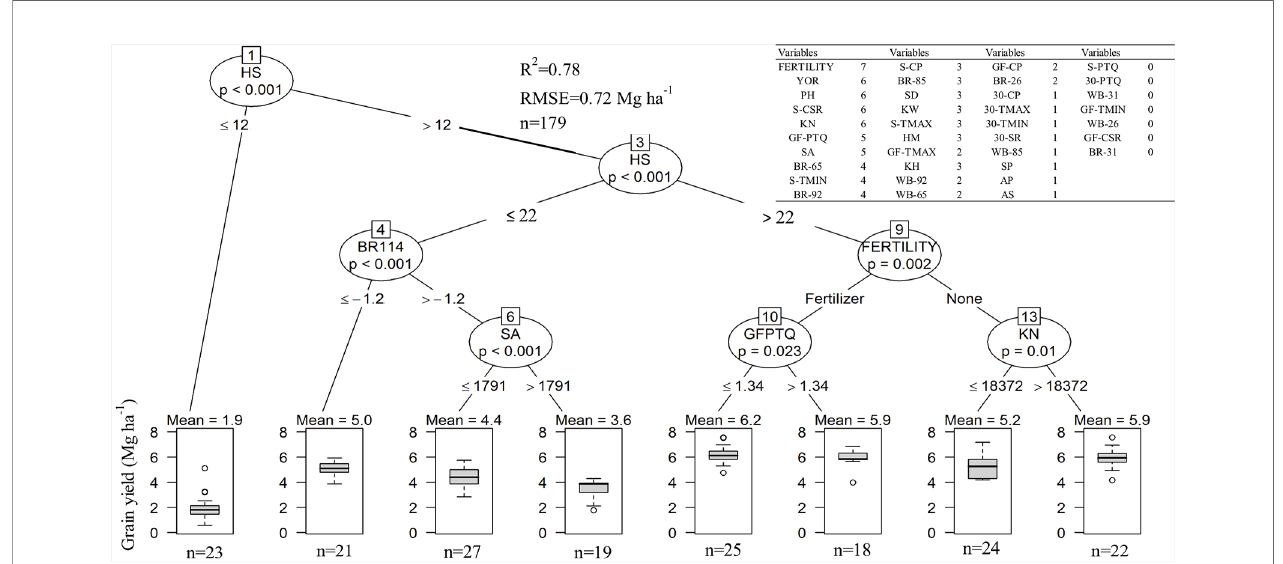
FIGURE 6 | Conditional inference tree for grain yield as related to weather, crop traits, and fertiliser across the entire data set. Boxplots spans fi rst to the third quartile, inside solid line are the means which are also shown above each boxplot. The lower and upper lines show the 5 th and 95 th percentile, respectively. Inset table shows a list of 37 candidate variables at in fl uencing wheat grain yield and the number of statistical models in which each variable was signi fi cantly associated with grain yield, out of a total of seven models. Year of variety release (YOR), plant height (PH), kernel number (KN), head number (HN), stem diameter (SD), kernel weight (KW), head size (HS), thermal time from sowing to anthesis (SA), from sowing to physiological maturity (AP), from anthesis to soft dough (AS), from sowing to physiological maturity (SP), maximum (TMAX) and minimum temperature (TMIN), cumulative solar radiation (CSR), cumulative precipitation (CP), photothermal quotient (PTQ), whole plant biomass (WB), crop biomass rate (BR). Letters left to each variable represent the period, growing season (S), thirty days before anthesis (30), grain fi lling (GF). Values to the right to each variable represent the growth stage in the Zadoks scale, GS 26, 31, 65, 85, and